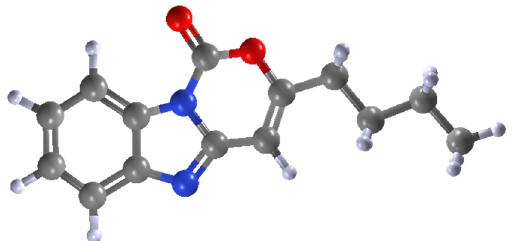
Figure 1. Molecular structure of 3-butyl-1 H -benzo[4,5]imidazo[1,2- c ][1,3]oxazin-1-one 2a . Color legend: carbon (light grey), hydrogen (white), oxygen (red), nitrogen (blue) (CCDC 2050576).